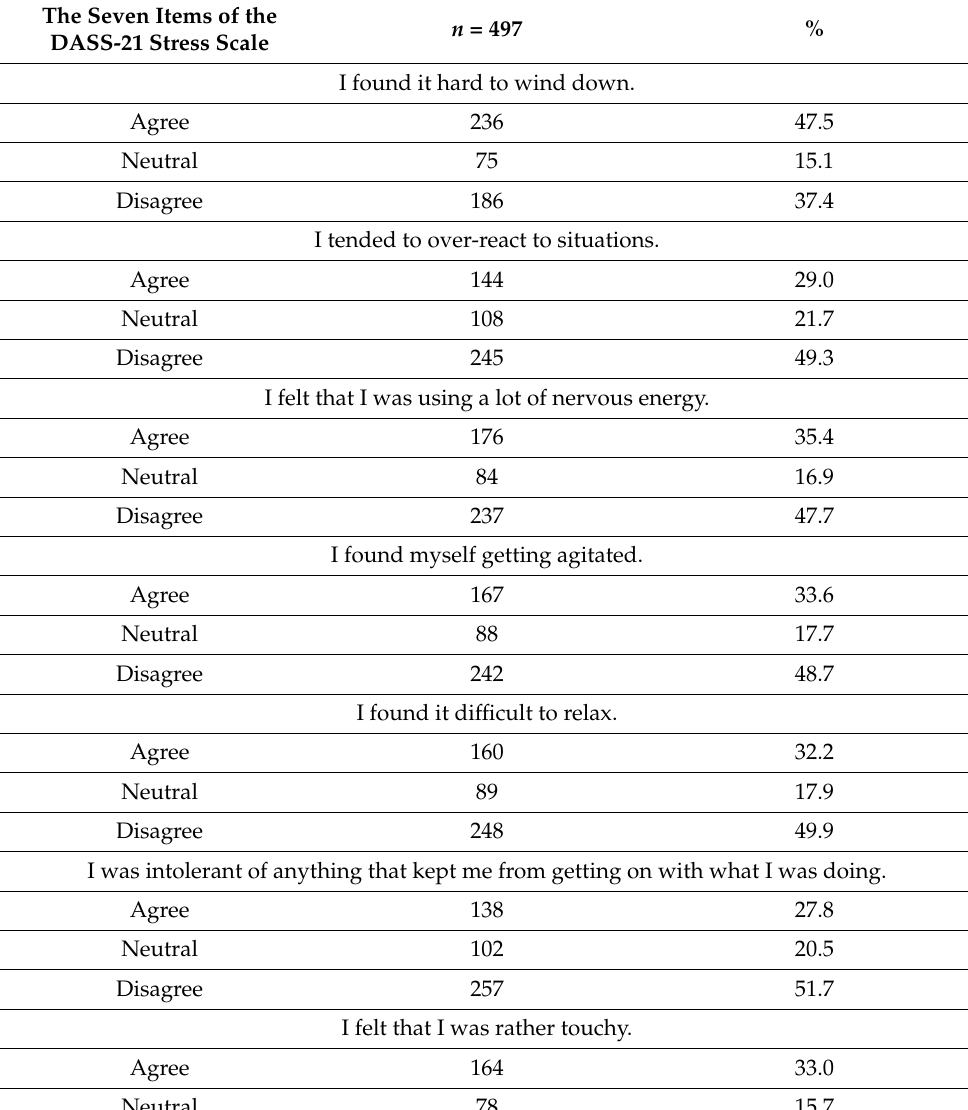
Table 2. The seven items of the DASS-21 stress scale reported by responders with COVID-19 infection. The Seven Items of the n = 497 % DASS-21 Stress Scale I found it hard to wind